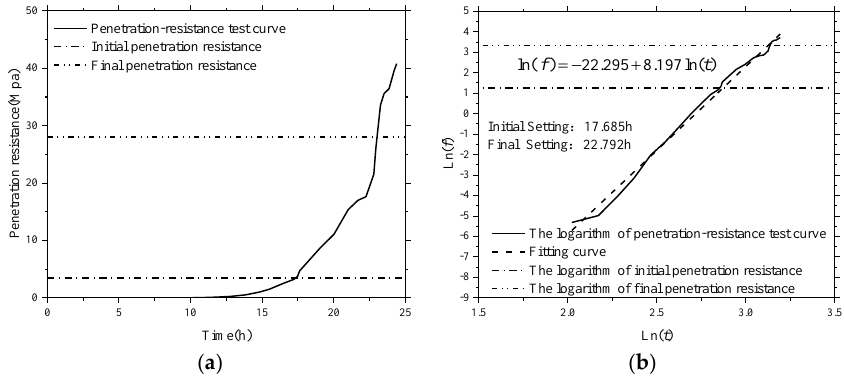
Figure 18. Typical penetration-resistance test results of SCC with 60% fly ash. ( a ) Penetration-resistance test curve; ( b ) the logarithm of penetration-resistance test curve. Table 6. Comparison of initial and final setting time obtained by SAs and penetration test.